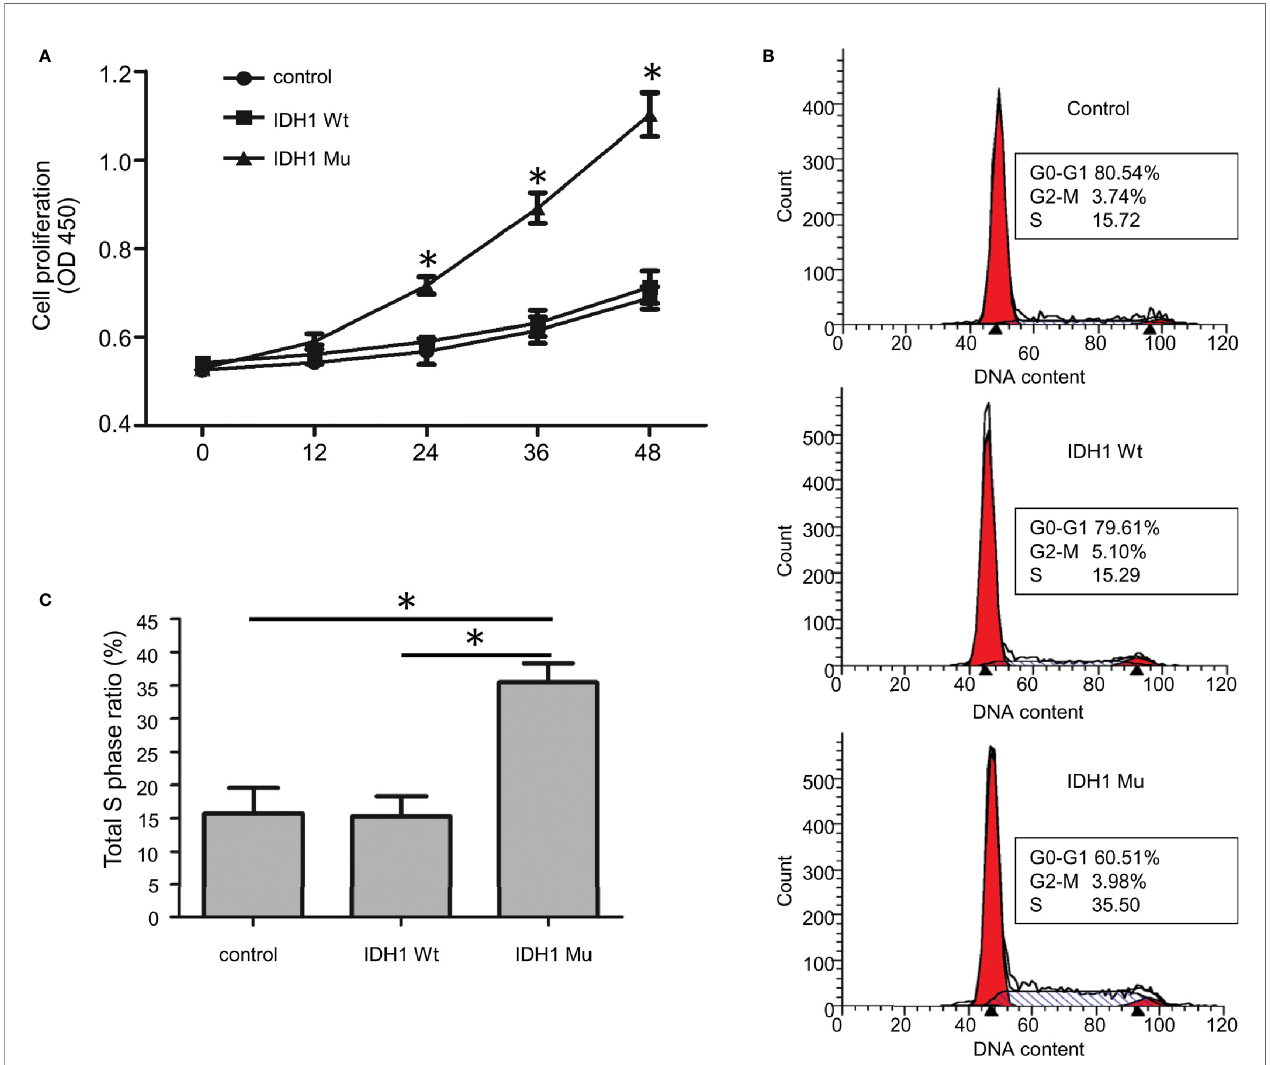
FIGURE 6 | The effect of the IDH1 R132C mutation on chondrocyte growth. (A) Proliferation results of chondrocytes after staining with WST-8 (n = 3). (B) Representative results of each group for cell cycle analysis. (C) A bar graphic fi gure shows the results collected from 3 independent replications. The IDH1 mu transduced cells manifested a signi fi cantly higher capacity for G1-S phase transition.